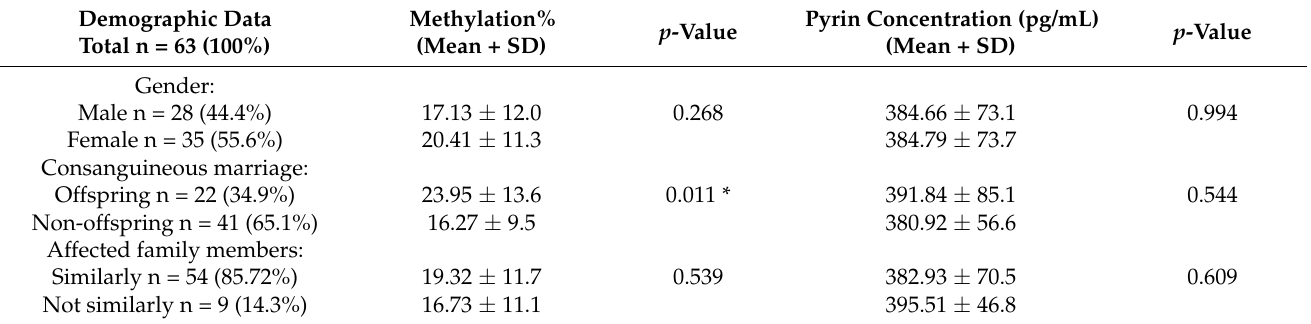
Figure 3. Correlation of the MEFV exon2 methylation% and the pyrin concentration among: ( a ) con ‐ trols; ( b ) FMF patients.